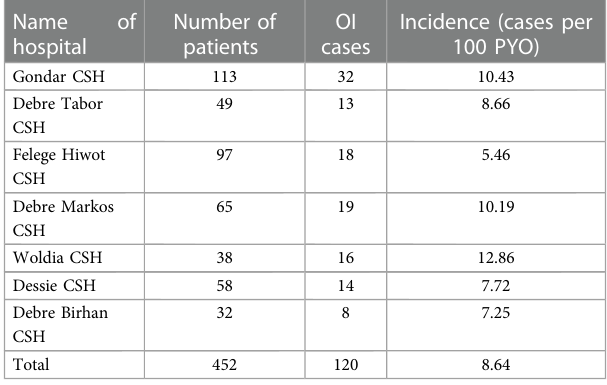
TABLE 5 Incidence of OIs by hospital among HIV-infected children receiving ART at Amhara regional state comprehensive specialized hospitals, Ethiopia, 2022 ( n =452).